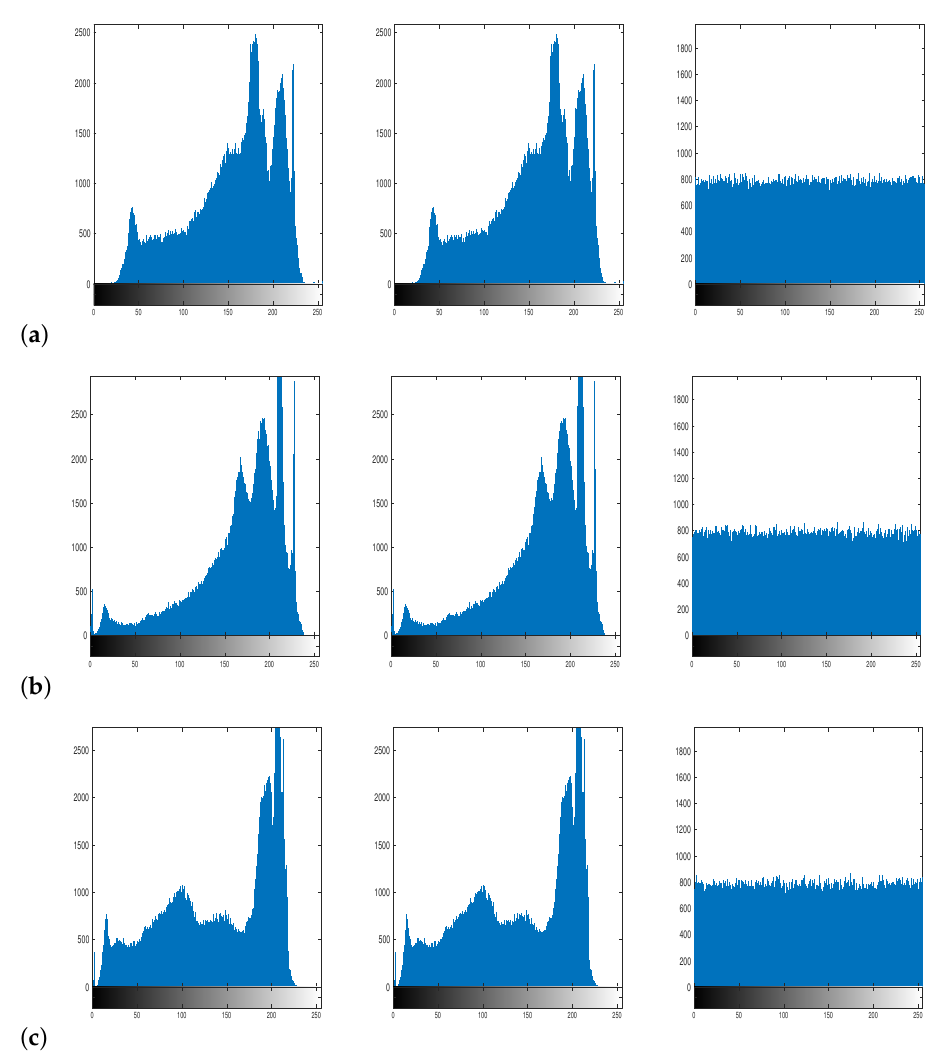
Figure 20. Similar to Figure 16 but for House image. Table 2. The variance of histogram obtained from the three experimental